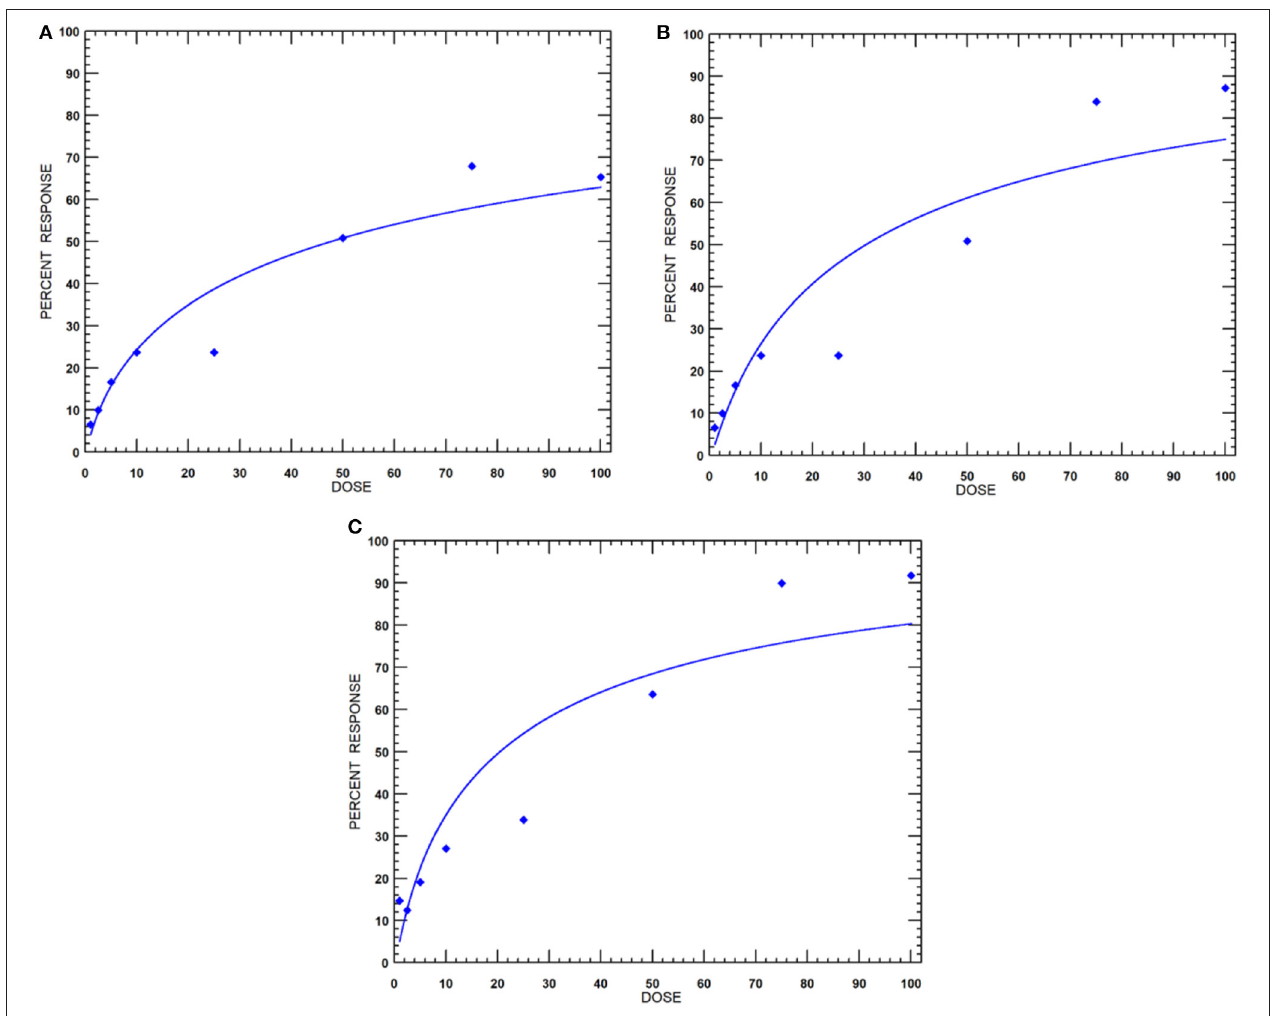
FIGURE 3 | Dose-response curves of MEO against M. incognita at incubation periods of (A) 24, (B) 48, and (C) 72h.